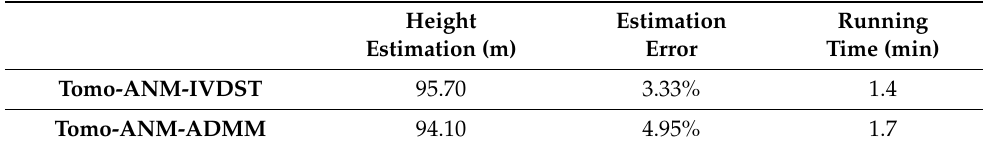
Table 4. Height estimation of Tomo-ANM-IVDST and Tomo-ANM-ADMM. Height Estimation Running Estimation (m) Error Time (min) Tomo-ANM-IVDST 95.70 3.33% 1.4 Tomo-ANM-ADMM 94.10 4.95%